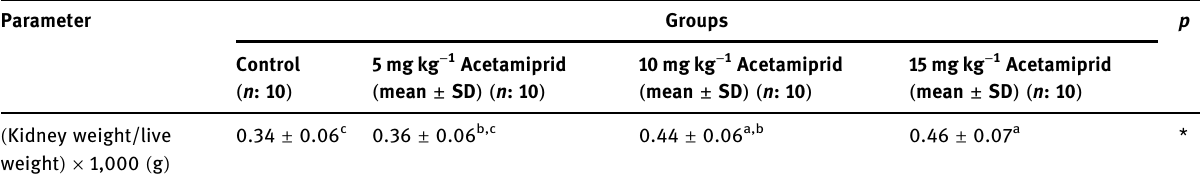
Table 1: E ff ects of acetamiprid on the kidney organ weight ( g ) between the groups Parameter